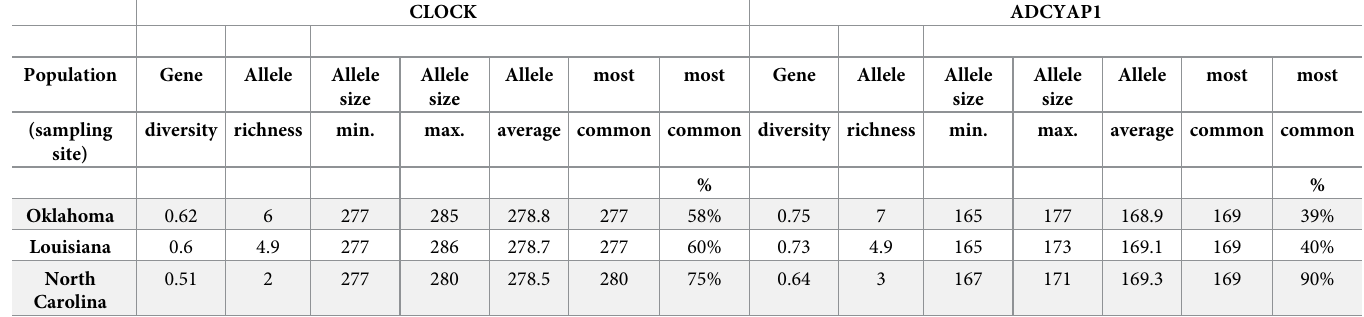
Table 1. Clock and Adcyap1 allelic variation across populations. Gene diversity, allelic richness, minimum and maximum allele size, allele average, and most common allele (also reported as a percentage) are presented for each